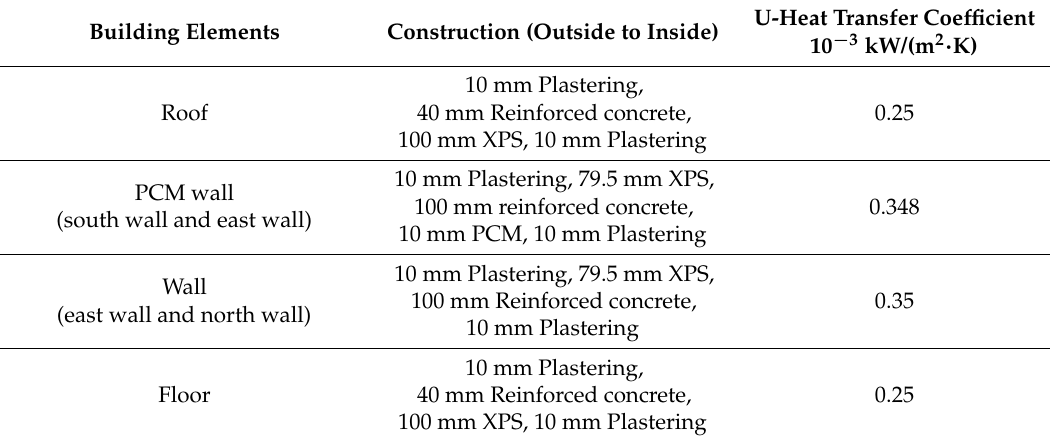
Table 1. Detail construction of the building and thermal properties of building materials.